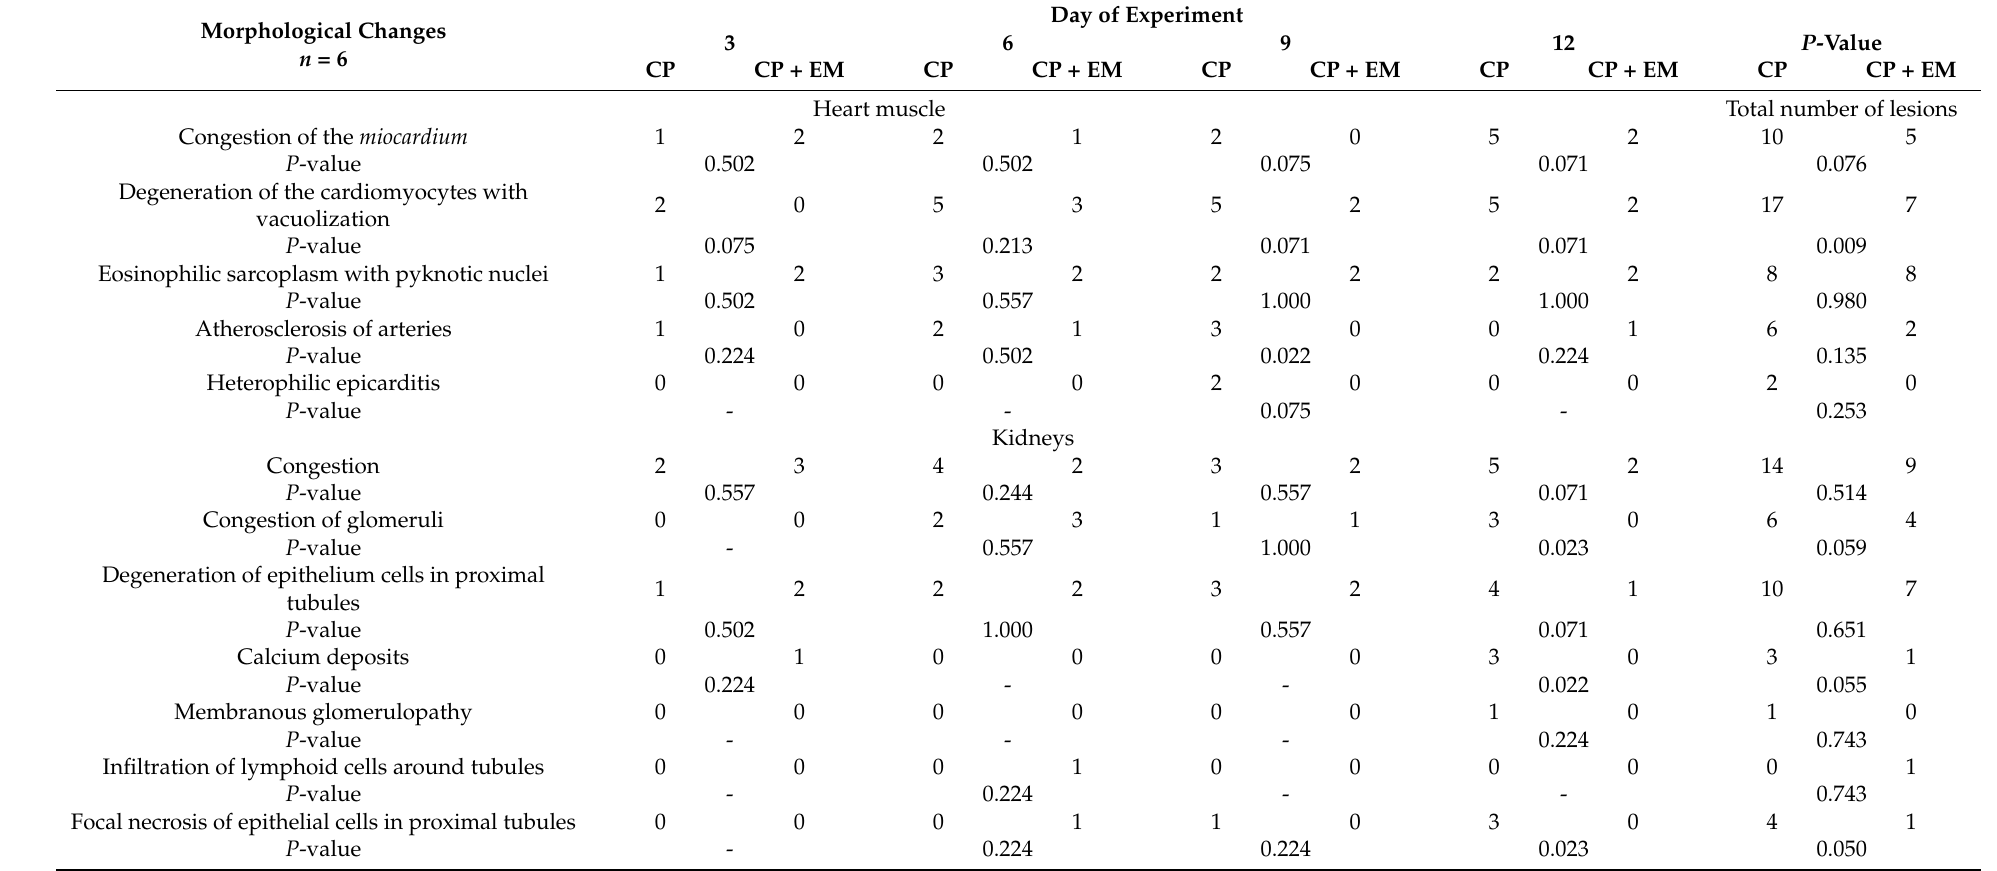
Table 3. Effect of EM supplementation on morphological lesions in the heart muscle and kidneys in quails challenged with C. perfringens